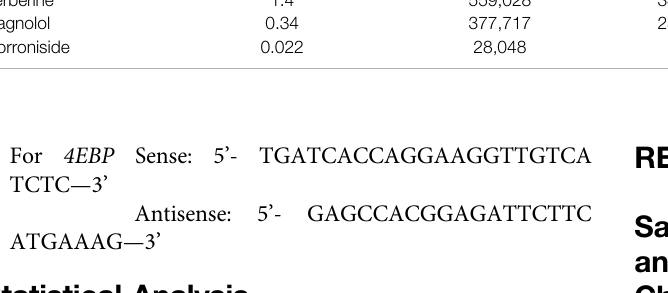
Frontiers in Pharmacology |